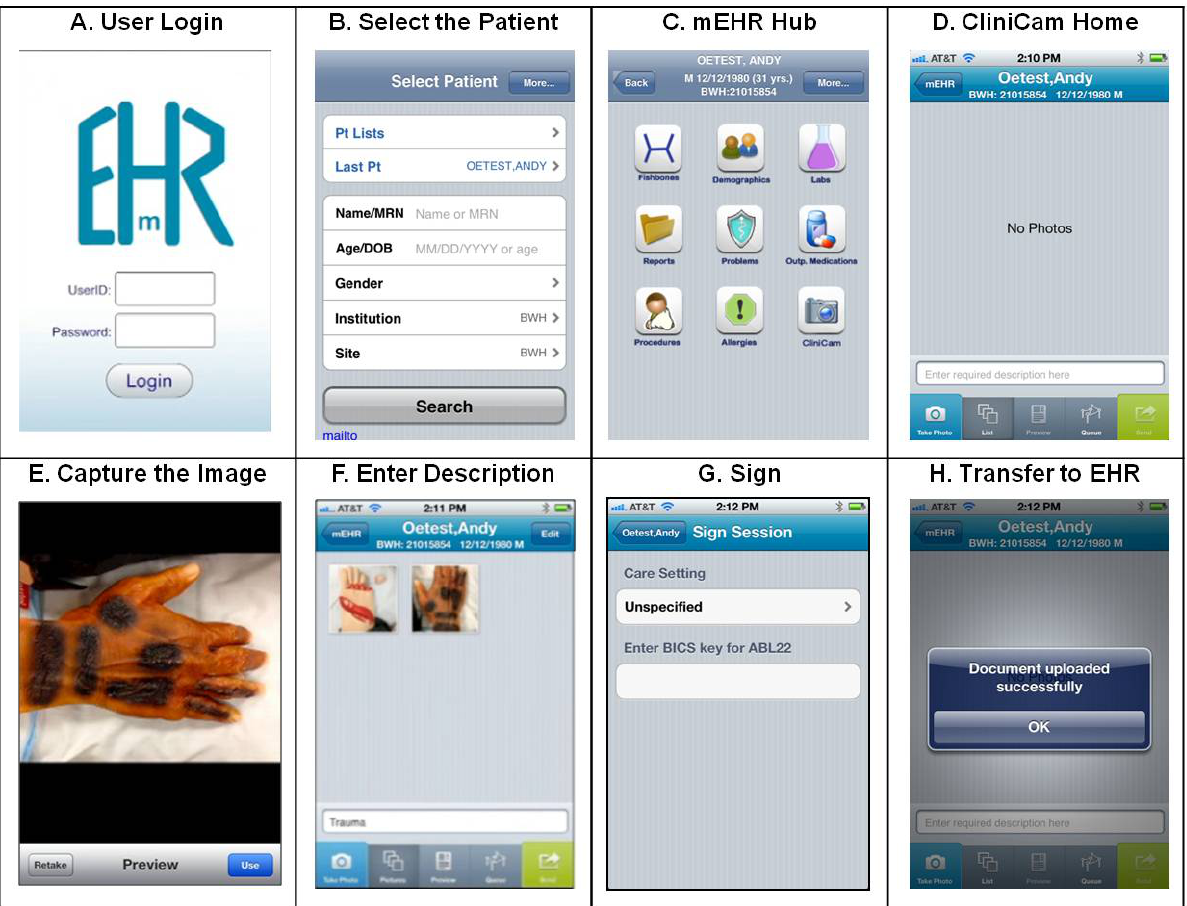
Figure 1. The CliniCam app. All patient and clinical information is fictitious. EHR=electronic health record; mEHR=partners mobile electronic health record